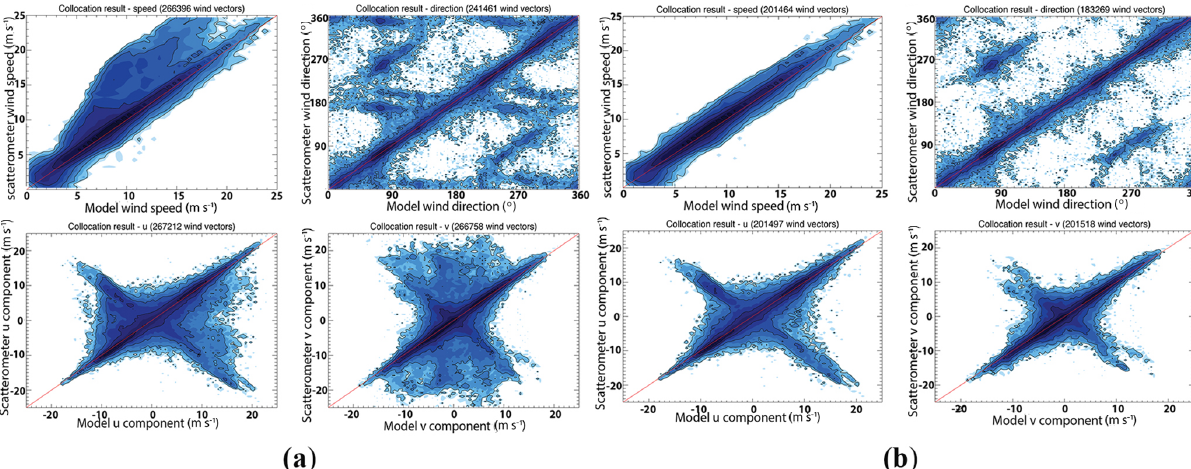
Figure 19. Contoured histograms of SeaWinds retrieved first rank wind solution versus input wind field for four orbits. (a) All WVCs within the swath; (b) excluding the WVCs in the outer swath, for which WVC numbers from 10 to 65 are included. From (a) to (b) , upper left: wind speed; upper right: wind direction; lower left: u component; lower right: v component. The contour lines are logarithmic.